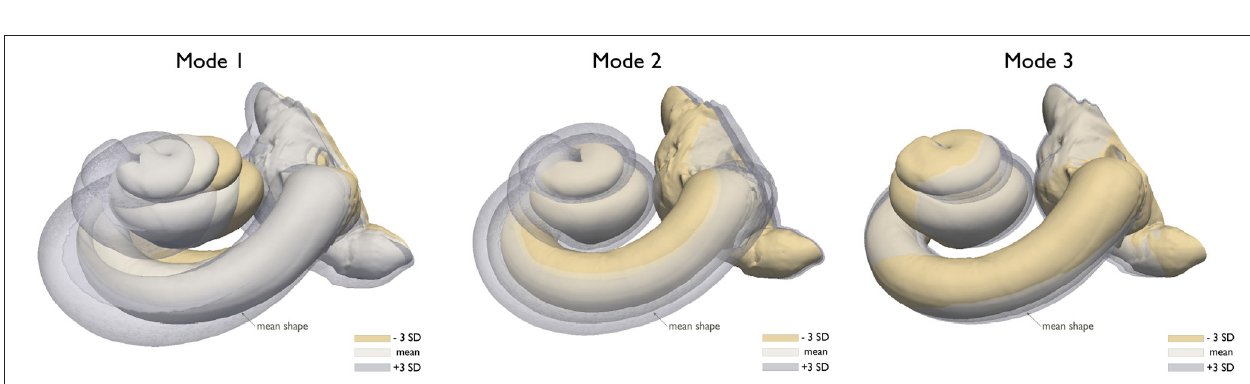
FIGURE 2 | Illustration of the changes of the cochlear morphology by varying the three first modes of variation of the SSM, mean shape, and ± 3 standard deviation (SD) from the